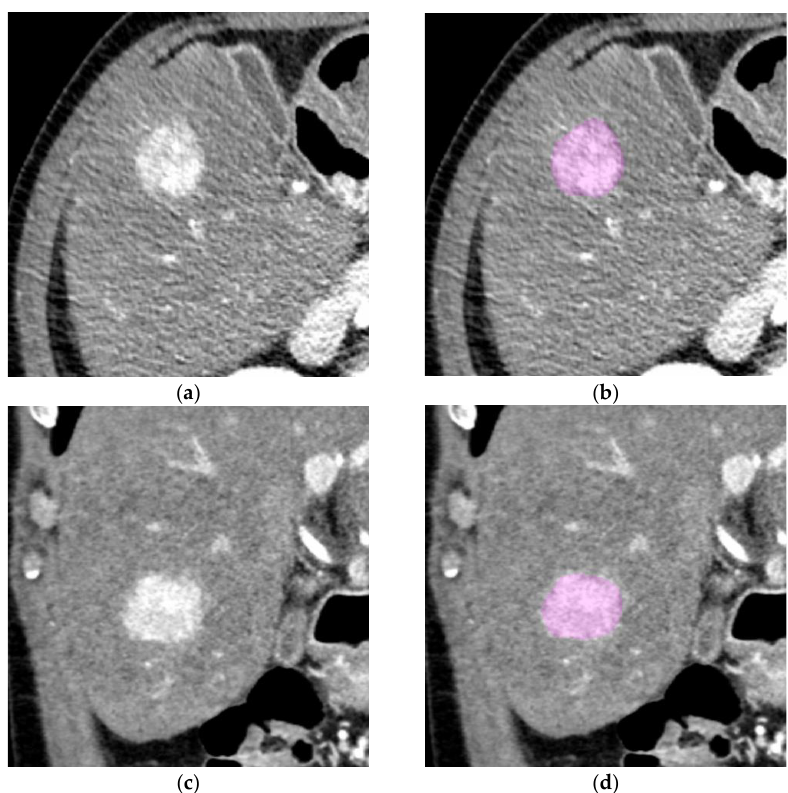
Figure 1. ROI segmentation of a tumor in the late arterial phase. ( a , c ) Exemplary axial and coronal slices of a sample tumor without PVI before segmentation; ( b , d ) exemplary axial and coronal slices of a sample tumor without PVI after segmentation.